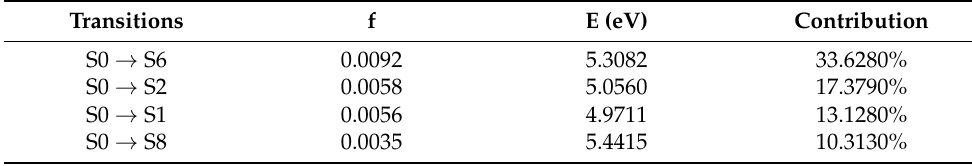
Table 2. Excited state transition with TD-DFT for